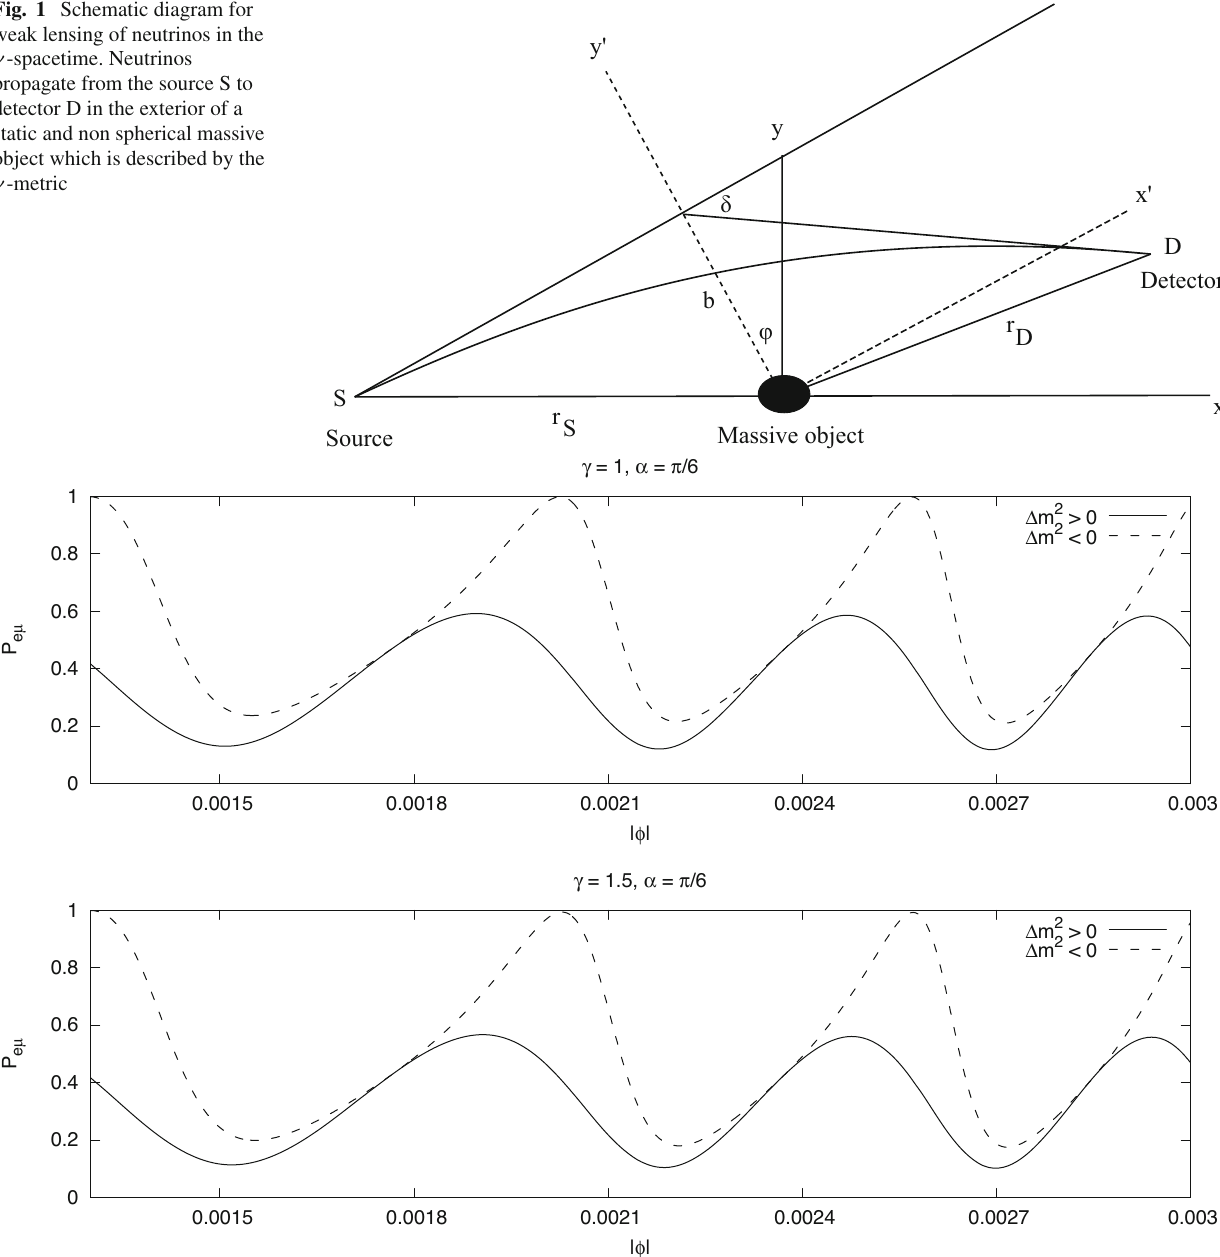
Fig. 2 Top panel: neutrino oscillation probability for γ = 1 . 0 when the mixing angle is α = π/ 6. Bottom panel: neutrino oscillation proba- bility for γ = 1 . 5 when the mixing angle is α = π/ 6. The solid and the dashedcurvesrepresentnormalhierarchyandinvertedhierarchyrespec-